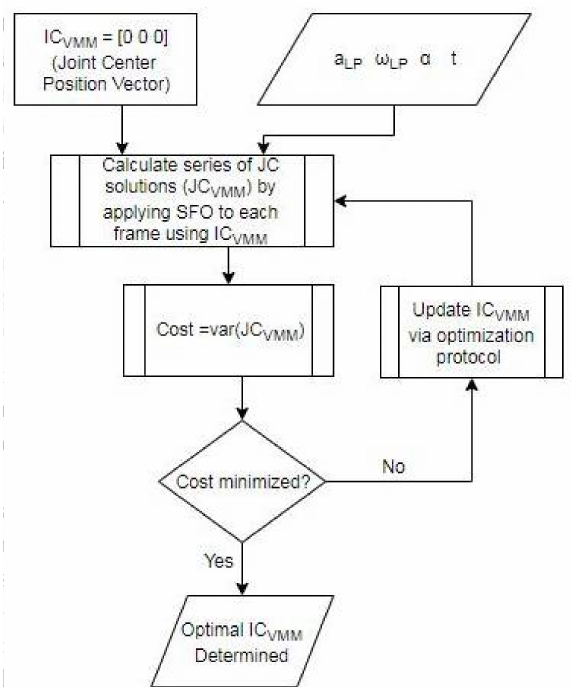
Figure 3. Flowchart detailing the variance minimization method process. The term “JC” denotes joint center, “var” denotes variance of, and “VMM” denotes variance minimization